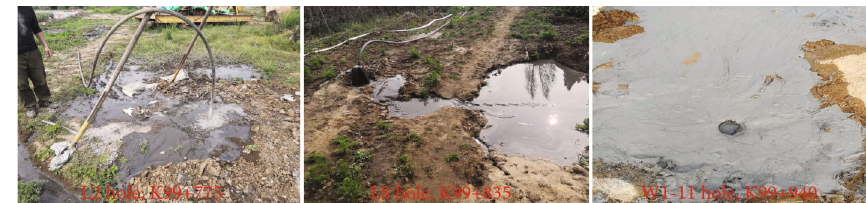
Figure 12: Field grouting.